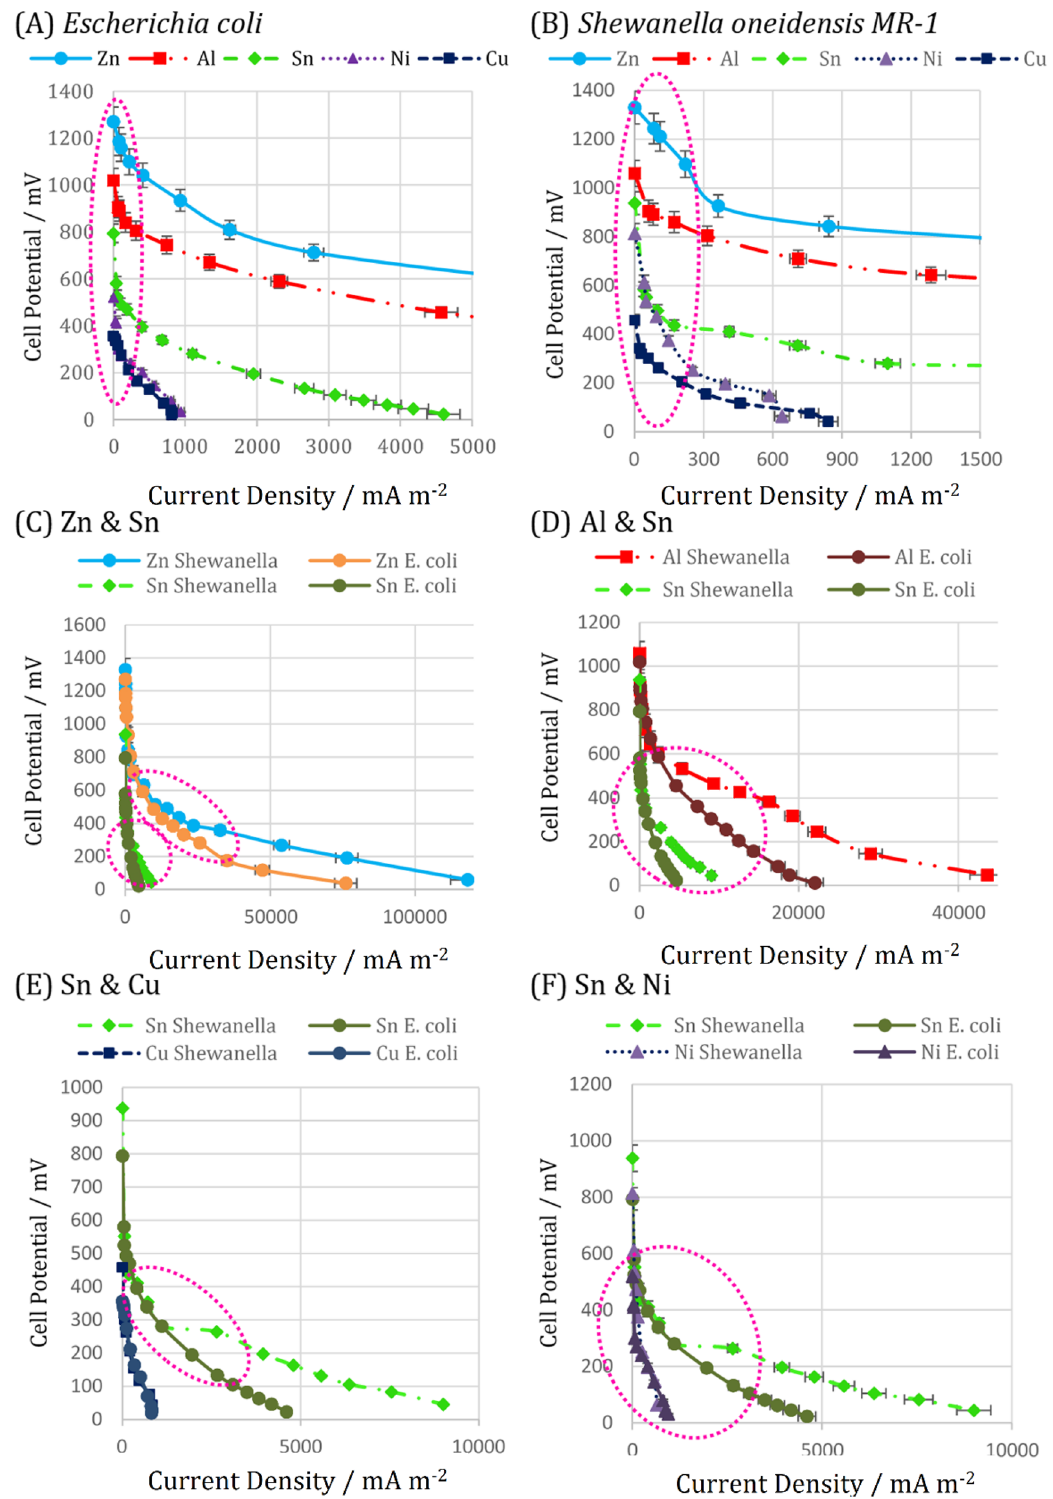
Figure 4. The comparison of activation and ohmic overpotentials of different electrodes and electron transfer mechanisms of the used biocatalysts by polarization curves. ( A ) Escherichia coli , ( B ) Shewanella oneidensis MR-1 , ( C ) Zn & Sn, ( D ) Al & Sn, ( E ) Sn & Cu, ( F ) Sn & Ni. The error bars represent the variation of power and current densities among repeated